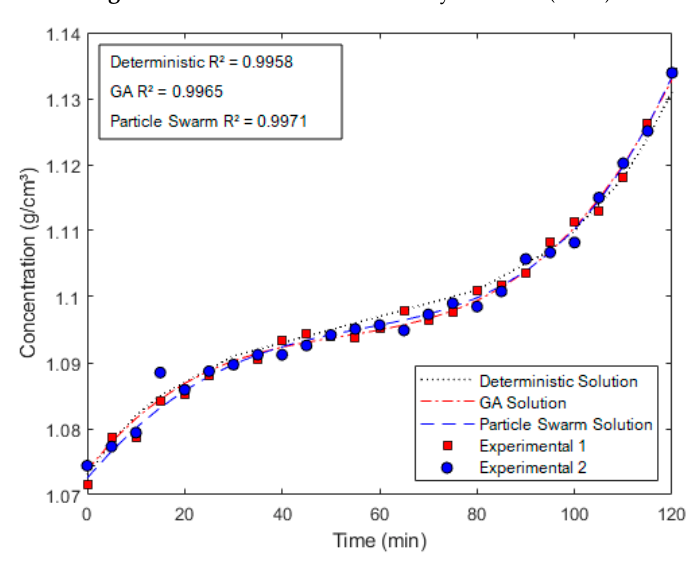
Figure 6. Model results—concentration g/cm 3 .